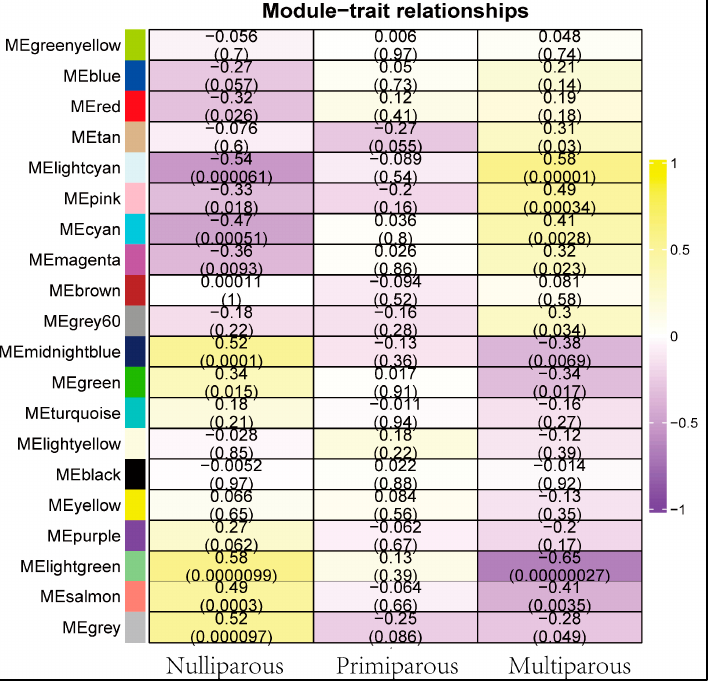
Figure 4. The correlation between the differentiation period and the modules. Correlation ranges from negative to positive according to the color, starting with purple and ending with yellow.